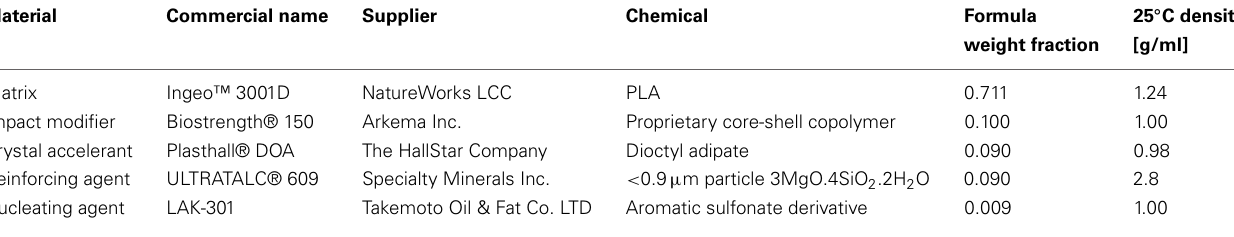
Table 14 | Formulation of the Ingeo™ 3801X grade